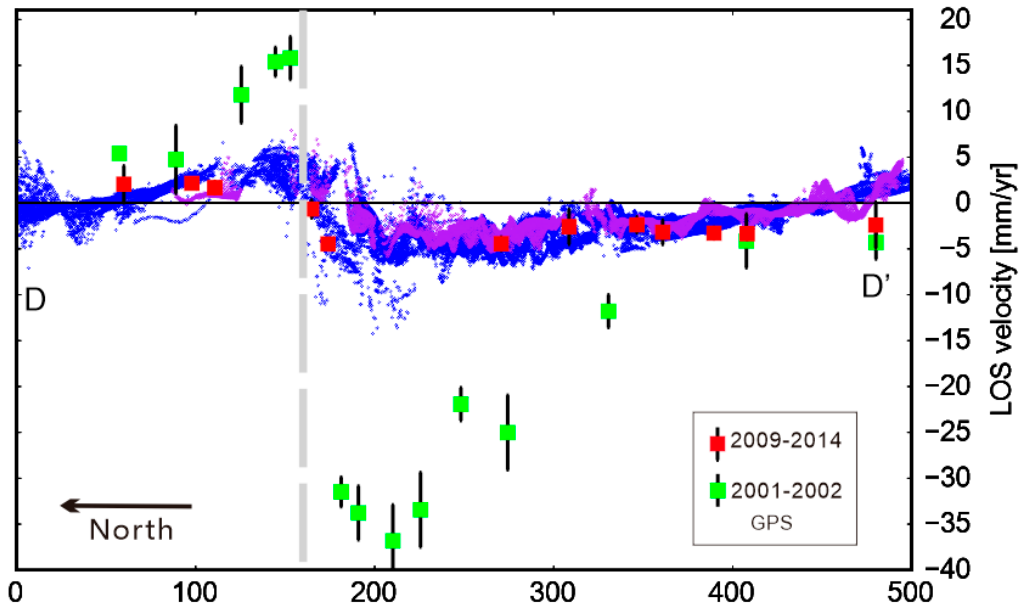
Figure 13. Comparison of postseismic InSAR LOS velocity at ~94°E and GPS observations projected along the across-fault profile DD’ shown in Figure 9. Green and red squares with 2-sigma errors bars represent the LOS-converted horizontal GPS velocities observed in 2001–2002 and 2009–2014, respectively. Blue and purple dots indicate the InSAR velocity observation during 2003–2010 and 2008–2011, respectively.